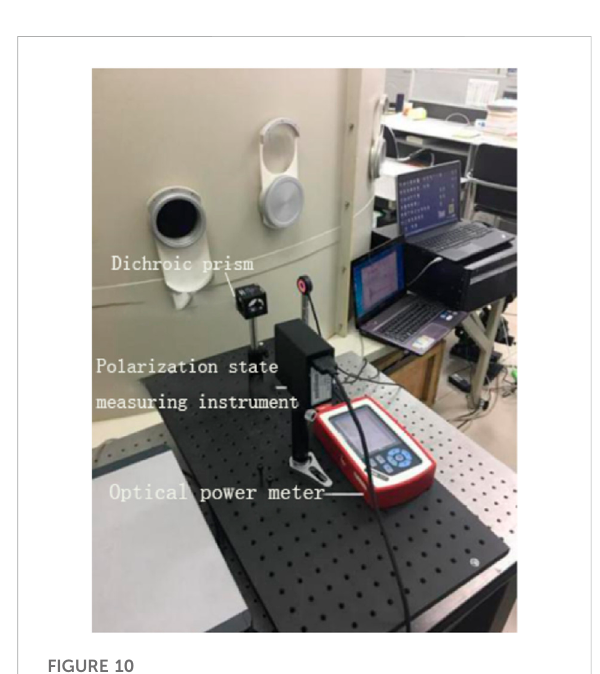
FIGURE 10 Physical illustration of receiving